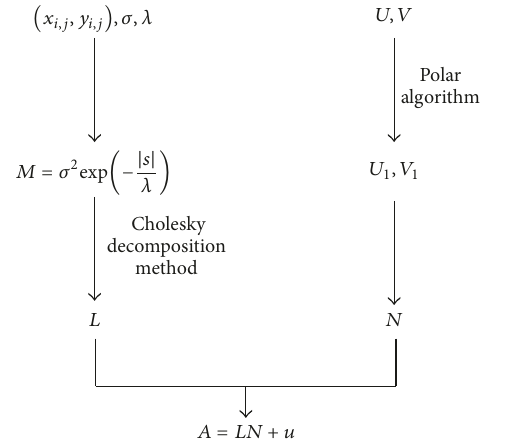
Figure 2: Generation process of the random aperture field.